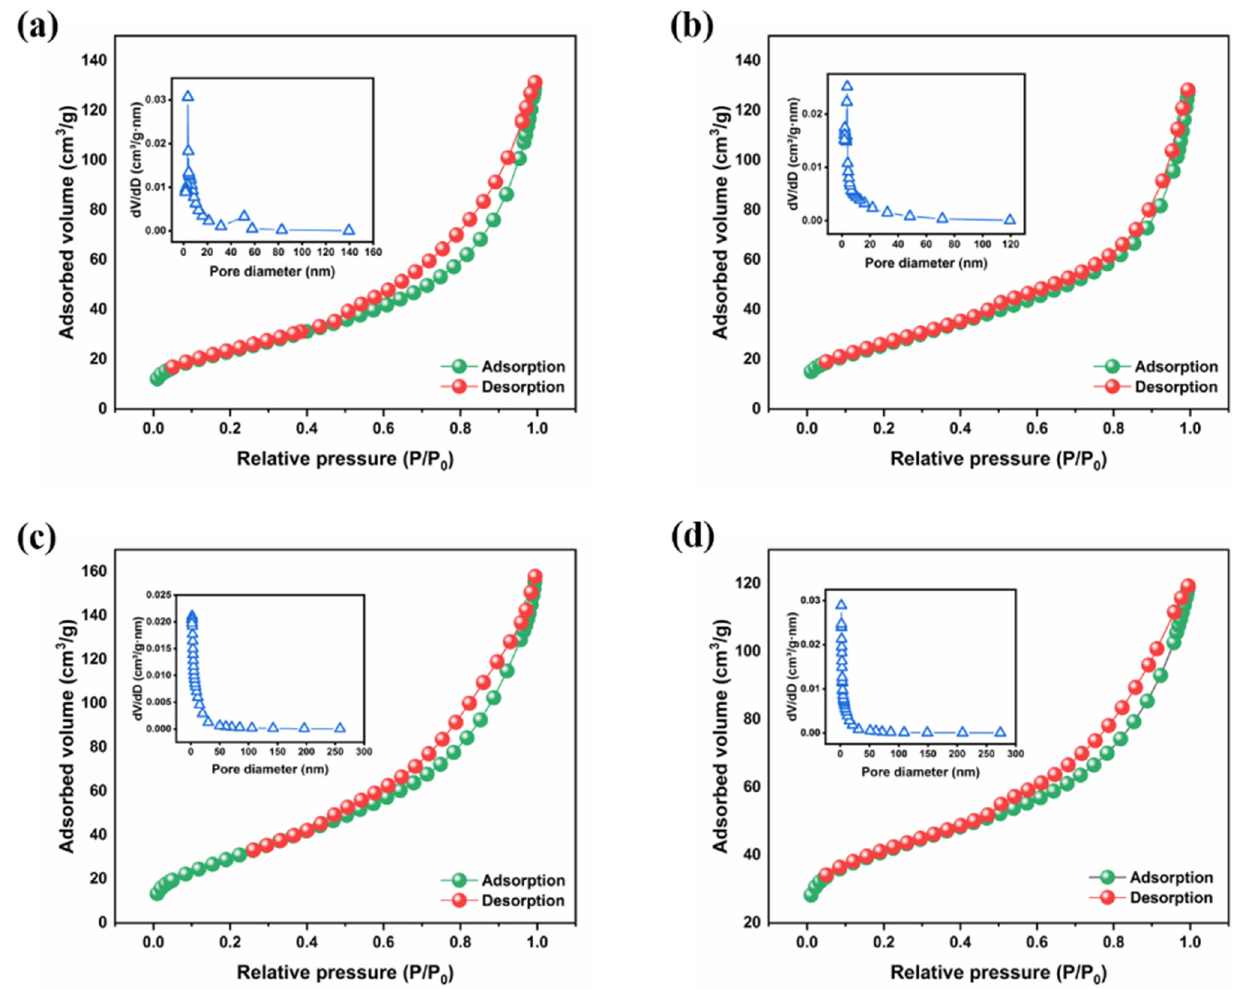
Figure 1. SEM images of ASBC400 ( a ), ASBC800 ( b ), and TEM images of ASBC400 ( c ) and ASBC800 ( d ).